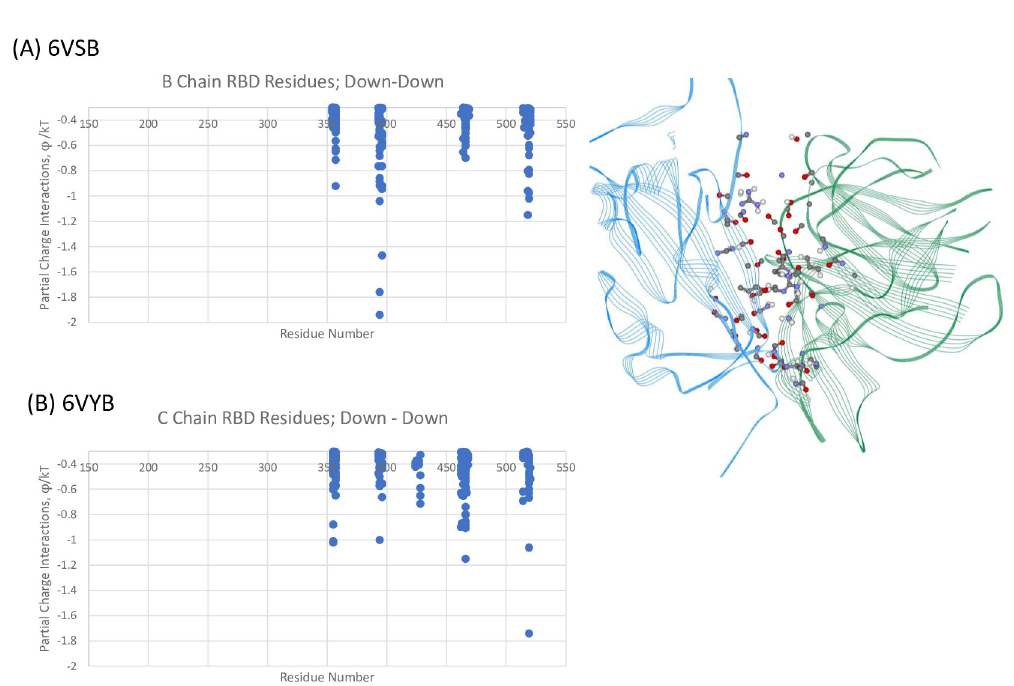
Fig 4. Dominant energy landscape for the interaction of the RBD of chain B (Down;blue) with the NTD of chain C (Down;green) for 6VSB; oblique, top view. Only B Chain residue/atoms are shown. (B) Mappings for Down-Down 6VYB. See S1